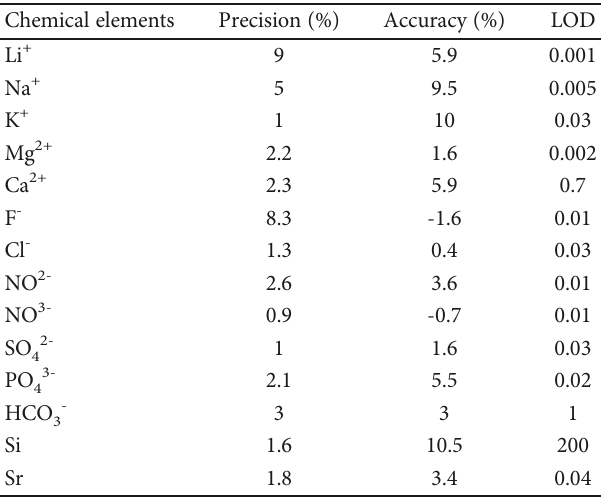
Table 1: Precision, accuracy, and detection limits for the elemental chemical